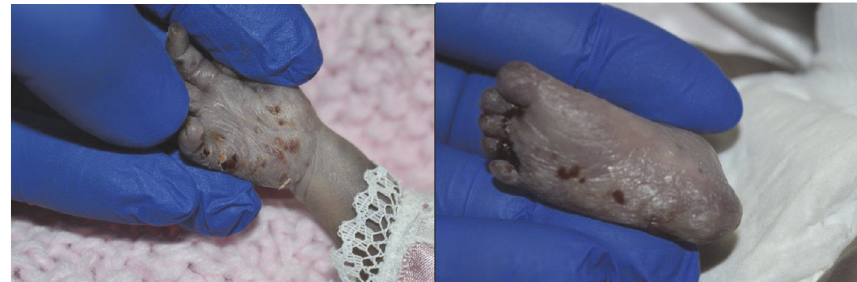
Figure 2: Neonatal vesicles present at birth. A swab was taken of the hand which confirmed HSV2 by